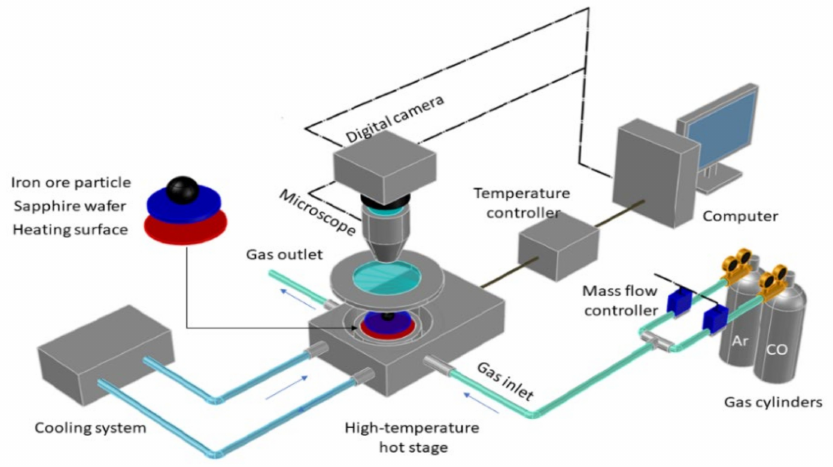
Figure 3. Schematic diagram of the high temperature hot stage microscope